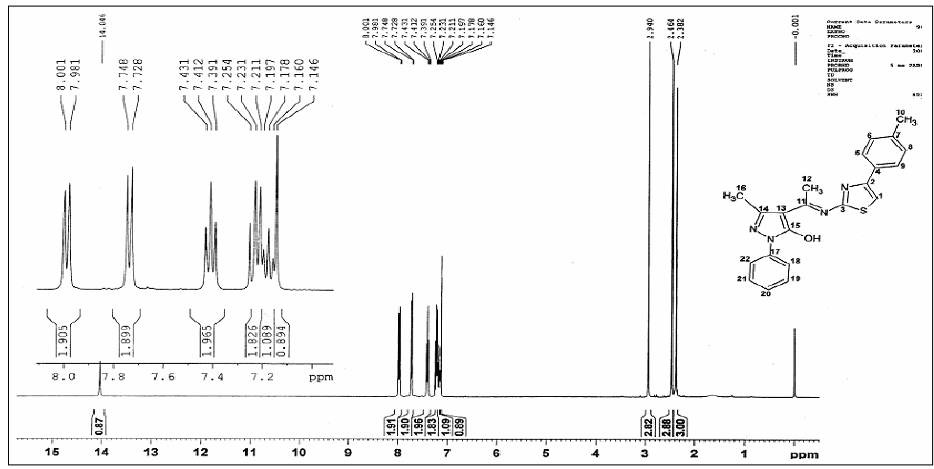
Figure 2. 1 H NMR spectra of